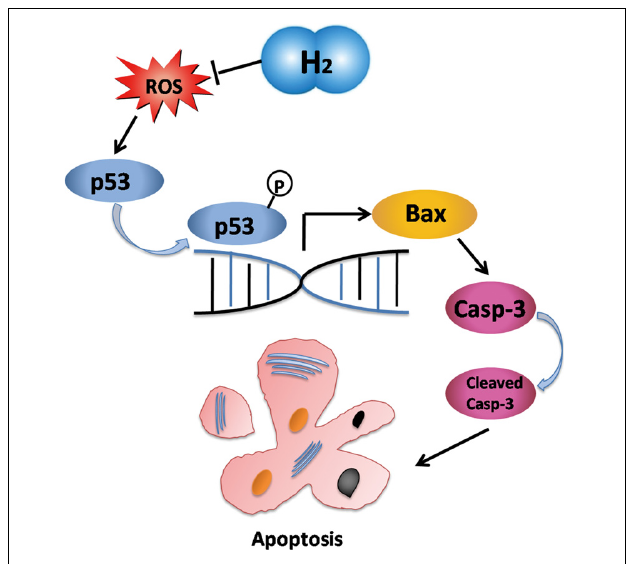
FIGURE 9 | Schematic depicting the mechanisms by which molecular hydrogen mediates apoptosis. H 2 eliminated oxygen free radicals which led p53 phosphorylation. As a transcription factor, phosphorylated p53 increased expression of Bax which increased expression of caspase-3. Cleaved-caspase-3 executed apoptosis of cardiomyocytes. Hence, apoptosis was suppressed by inhibition of p53 in response to molecular